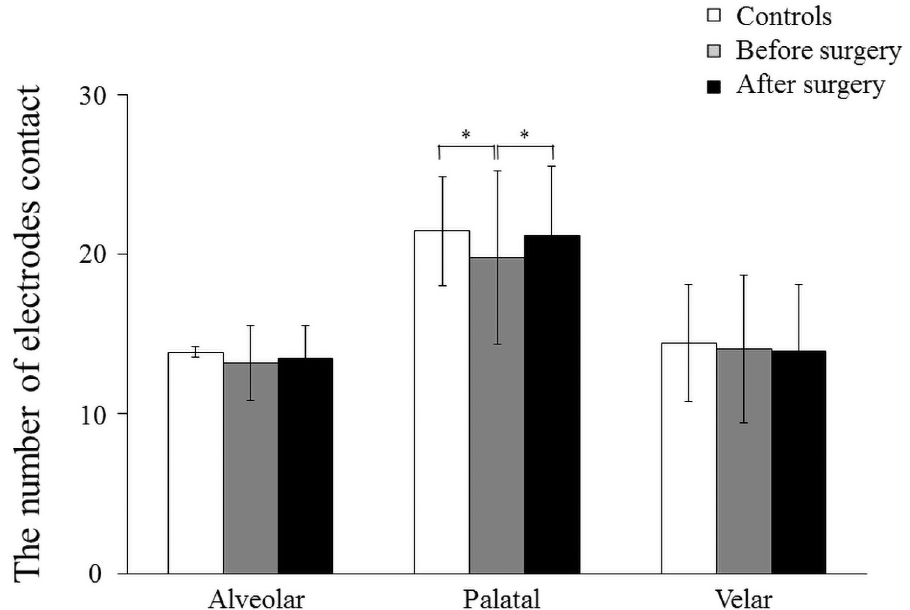
Fig 5. Mean and standard deviation in the number of electrodes contact of alveolar, palatal and velar part in the controls, patients before surgery, and after surgery. 0.2 seconds before complete tongue-palatal contact ( � : p < 0.05, �� : p <